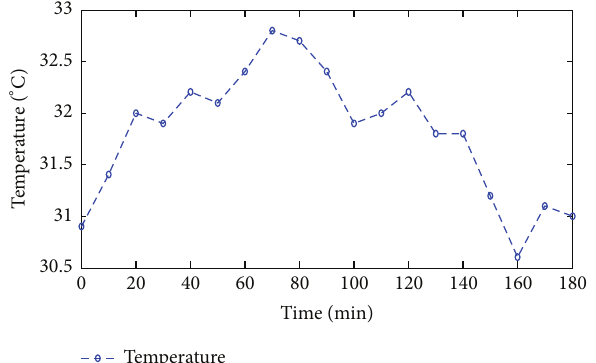
Figure 11: Temperature-time on day six (12:00–15:00 daily).